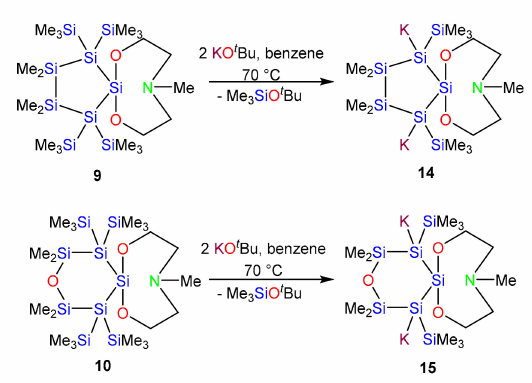
Scheme 6. Conversion of spirocyclic oligosilanylsilocanes 9 and 10 to the respective oligosilane diides 14 and 15